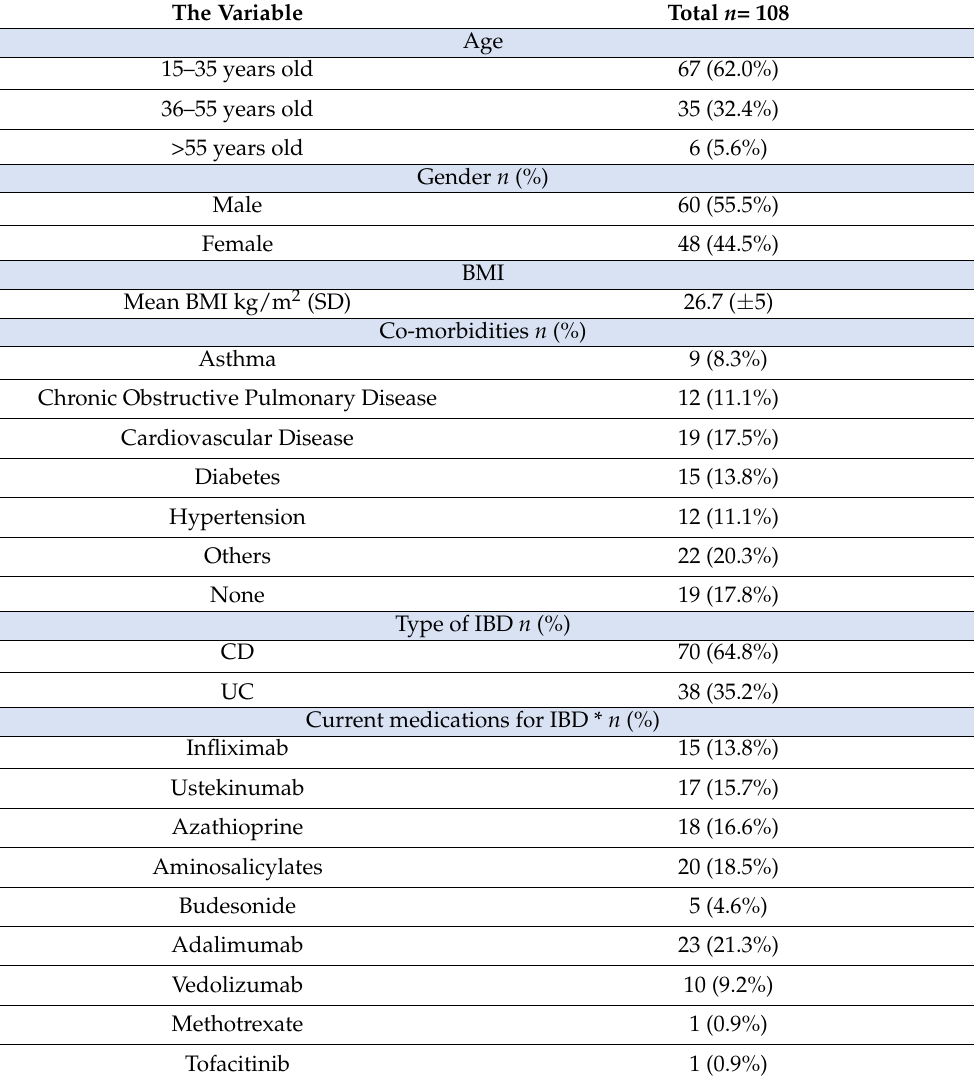
Table 1. Demographic characteristics of the patients. The